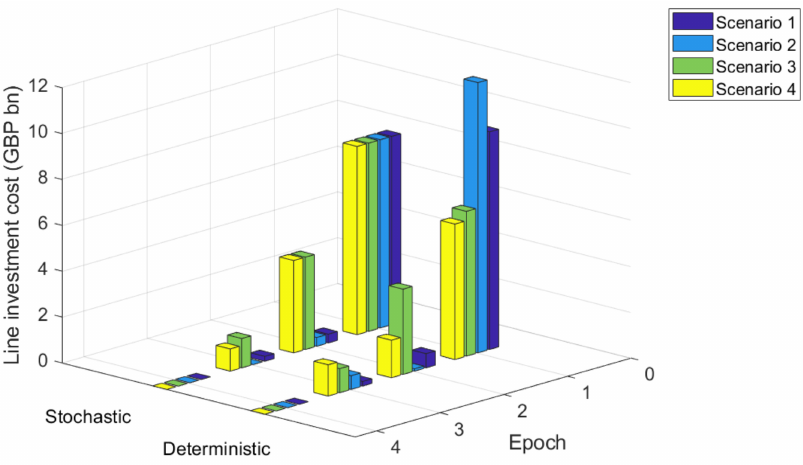
Figure 24. Optimal investment cost in line reinforcement for the deterministic and stochastic formu- lations for each epoch and